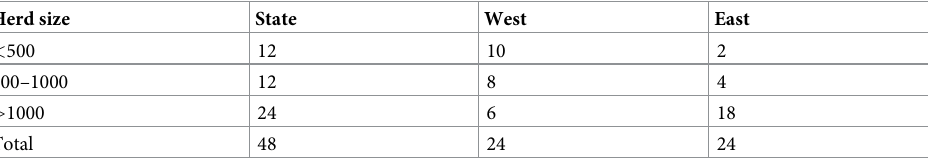
Table 1. Number of responding dairy farms by herd size across the state and by region (West and East). Herd